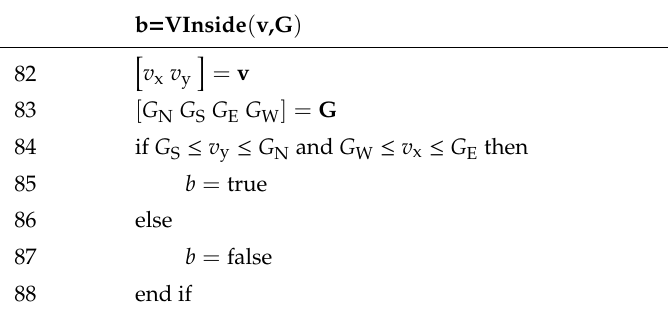
Table 7. Valid velocity